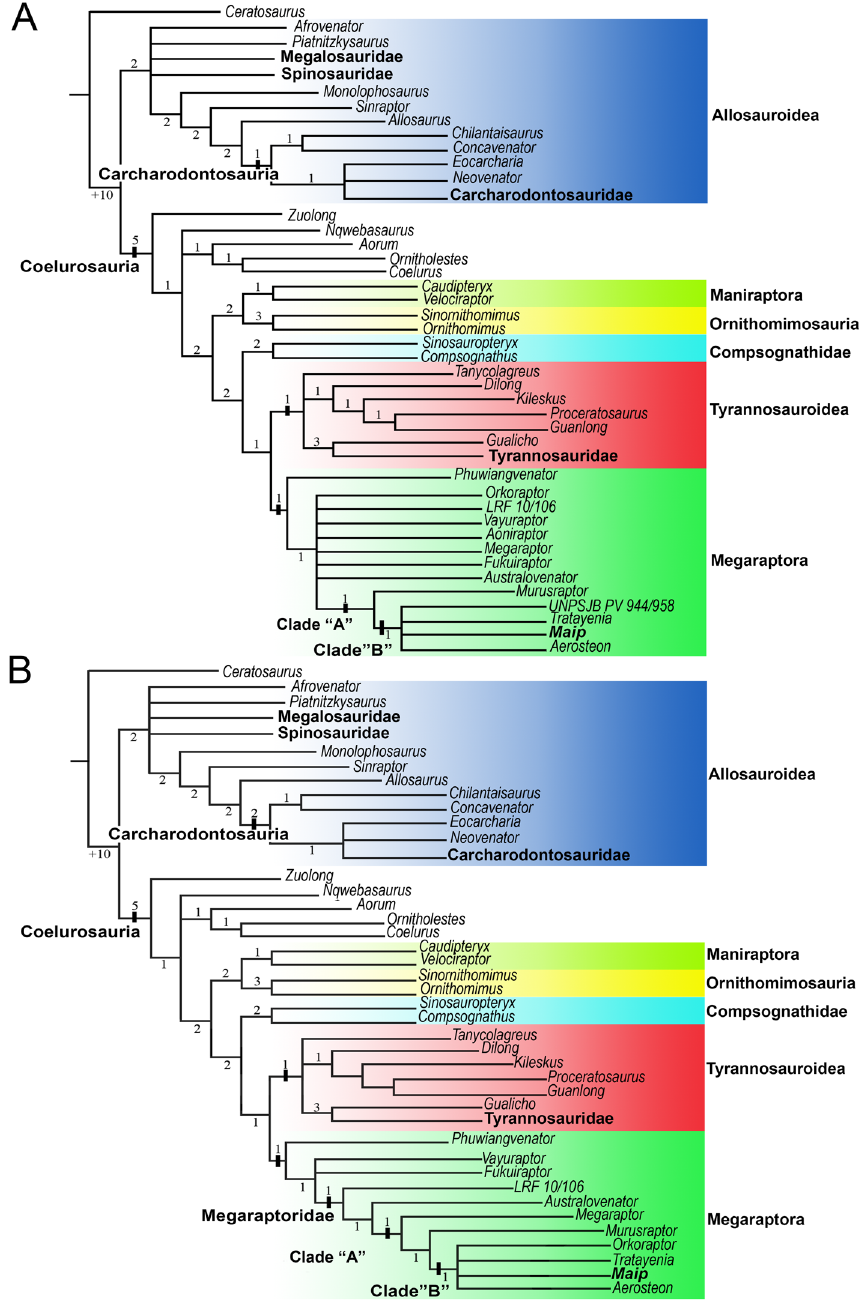
Figure 15. Phylogenetic relationships of Maip of the analysis with ( A ) and without ( B ) fragmentary taxa. Numbers represents Bremer values for each